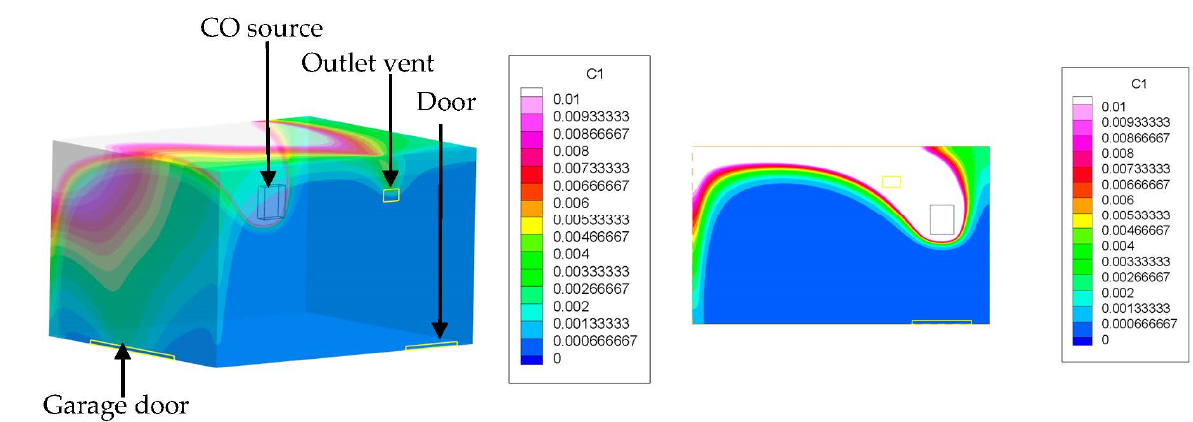
Figure 7. CO distribution in the garage—case 4 (concentration of CO in kg/kg).